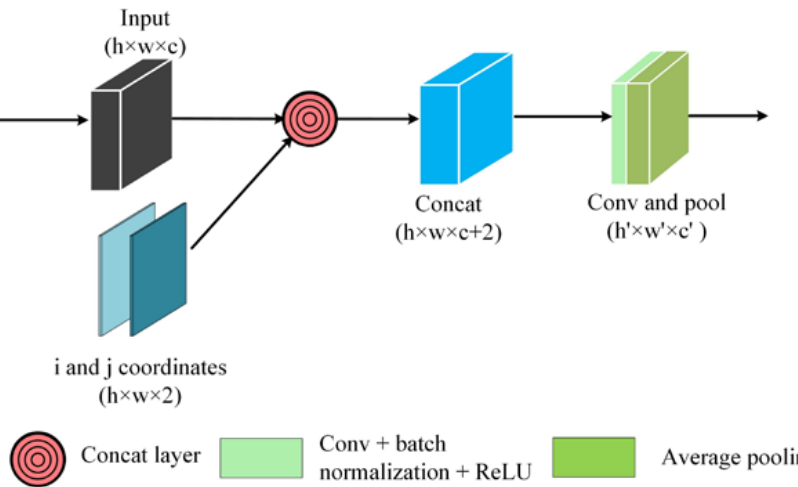
Figure 5. The CoordConv added to two coordinate channels after the feature map was inputted: one for i and one for j coordinates (h and w represent the sizes of the feature map).